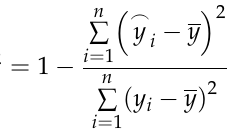
Figure 10. Prediction error of each model test set. ( a ) Efficiency prediction error of each model. ( b ) Flow prediction error of each model.